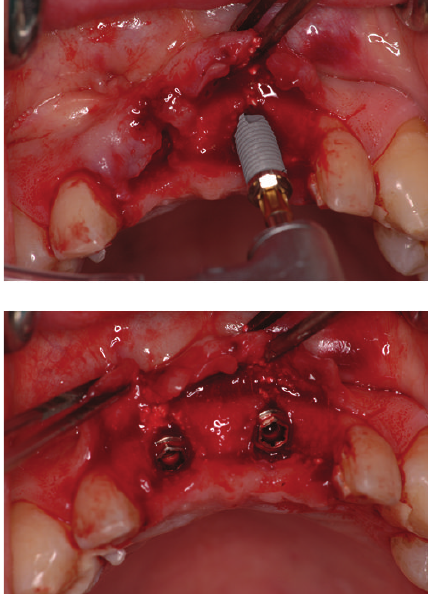
Figure 6: Two 13mm long implants with a 3,75 mm diameter were